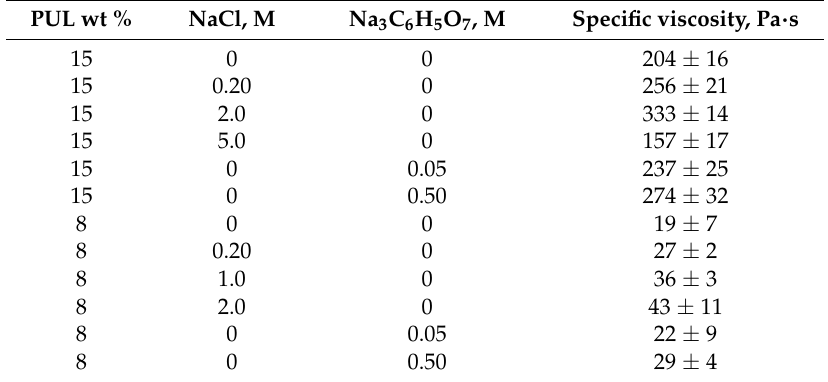
Table 1. Specific viscosities of PUL solutions with various NaCl or Na 3 C 6 H 5 O 7